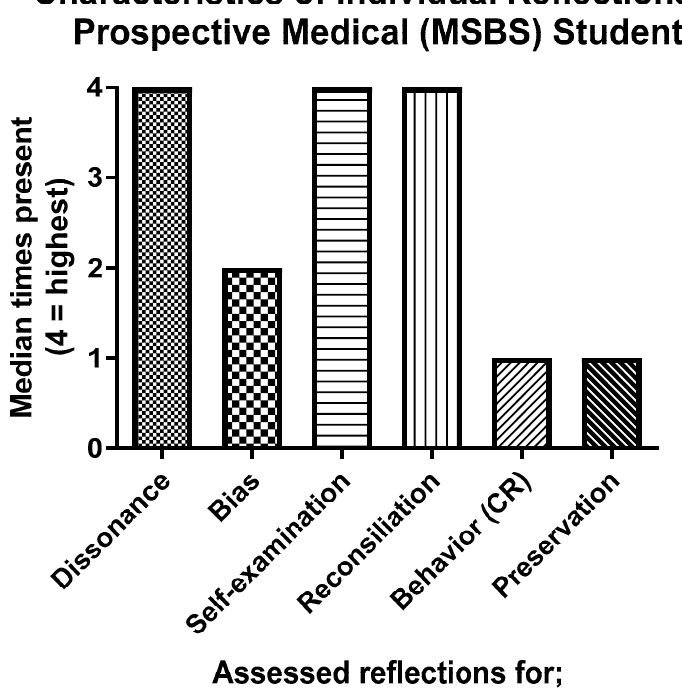
Figure 1. Characteristics of individual written reflections by prospective medical (MSBS) students. The median frequencies of dissonance, bias (and its mitigation), self-examination, dissonance reconciliation, compassionate behavior (CR), and preservation by each student on four separate occasions were calculated from 100 individual written reflections (four per student). One of the 26 MSBS students did not express dissonance on any occasion, and was, thus, a statistically significant outlier ( p < 0.01) and was not included in the analyses. Dissonance, self-examination, and dissonance reconciliation all occurred more frequently than bias mitigation, compassionate behavior (CR), and preservation ( p < 0.01). Nevertheless, the medians are all greater than zero ( p < 0.0001). For example (from Appendix A);